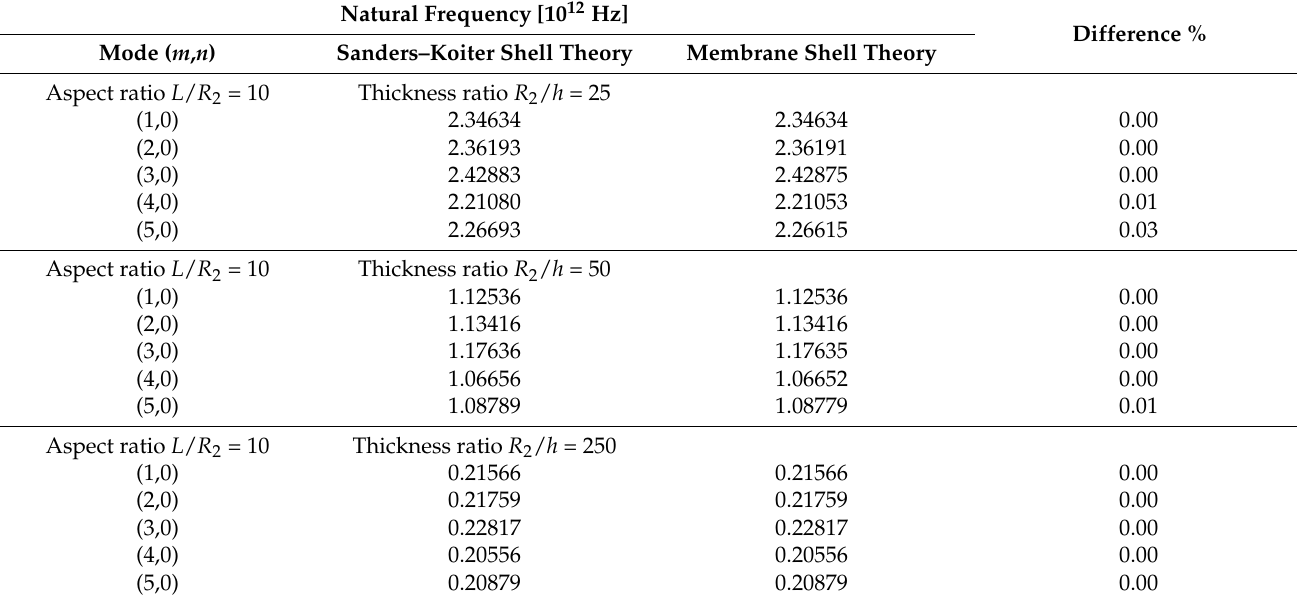
Table 3. Simply supported DWCNT with aspect ratio L / R 2 = 10 and thickness ratios R 2 / h = (25,50,250). Axisymmetric modes ( n = 0). Comparisons between Sanders–Koiter and membrane shell